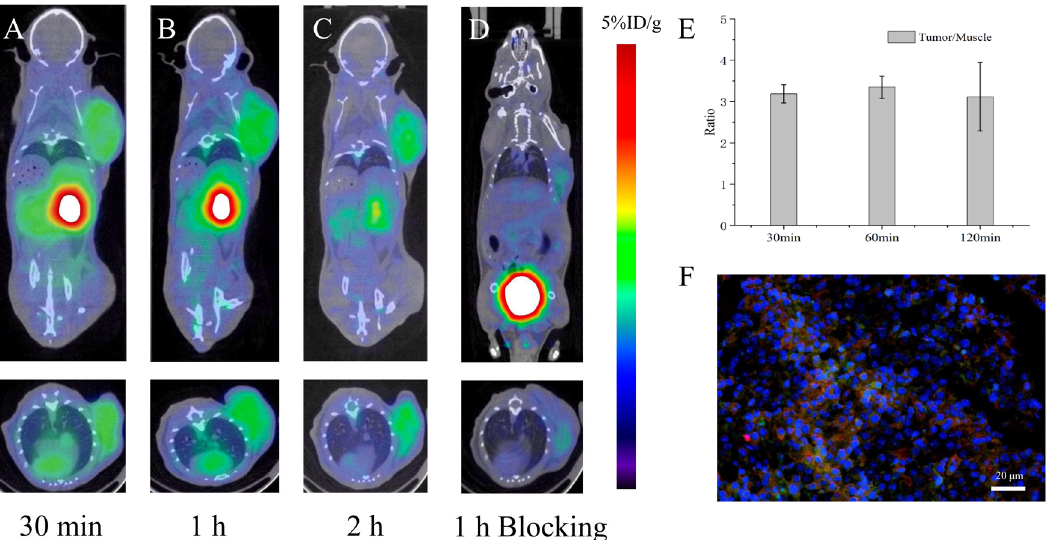
Figure 4. ( A – C ) PET images of the B16F10 tumor-bearing mice 30 min, 1 h, and 2 h after injection of [ 68 Ga]Ga-DOTA-M2pep, respectively ( n = 4). ( D ) PET images of the blocking groups 1 h after injection of [ 68 Ga]Ga-DOTA-M2pep. The arrows indicate the tumor regions ( n = 3). ( E ) Tumor-to-muscle (T/M) ratios in B16F10 tumor-bearing mice at different time points. ( F ) Immunofluorescence of tumor sections. Tumor sections were stained with FITC-M2pep (green), CD206 (red), and DAPI (blue) after micro-PET imaging.